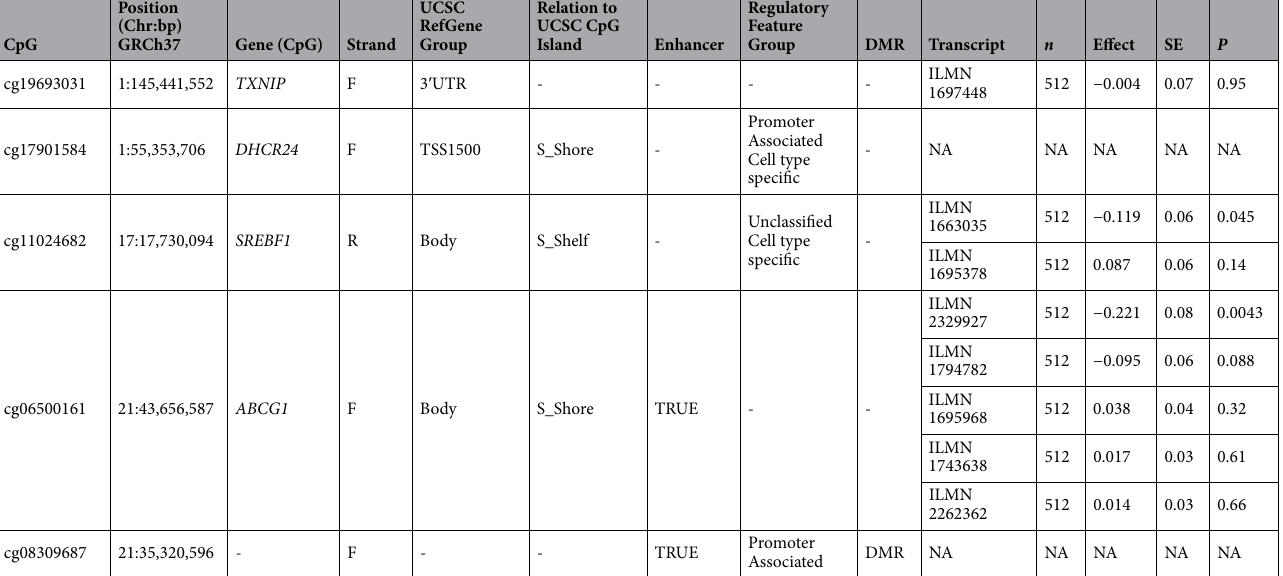
Table 5. Gene expression—CpG M value associations of successfully replicated CpG methylation sites. CpG cytosine–guanine dinucleotide, Chr chromosome, bp base pair, GRCh37 the Genome Reference Consortium human genome (build 37), UCSC University of California Santa Cruz, DMR differentially methylated region, SE standard error. Annotation information for CpG methylation sites is received from the annotation file of Illumina Infinium Human Methylation 450